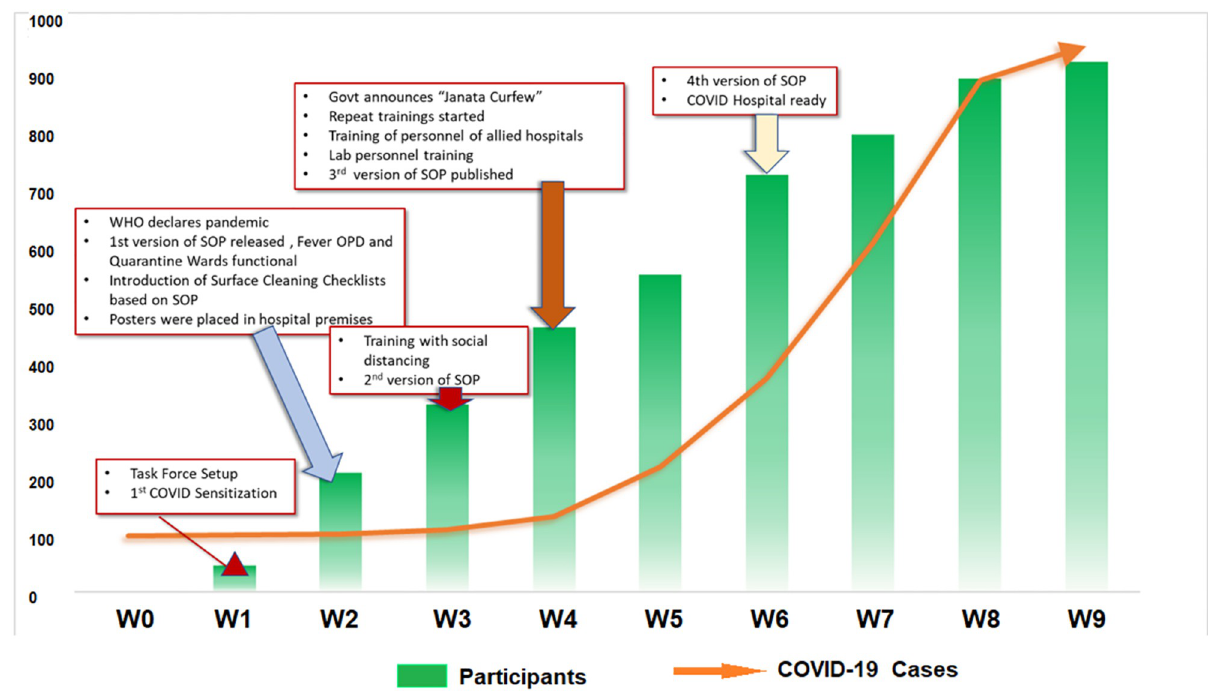
Fig 3. Weekly advancement in the IPC training activities at the study centre and growing number of COVID-19 cases in the country at the beginning of the pandemic (W0 in the figure stands for the first week of the month of March 2020).